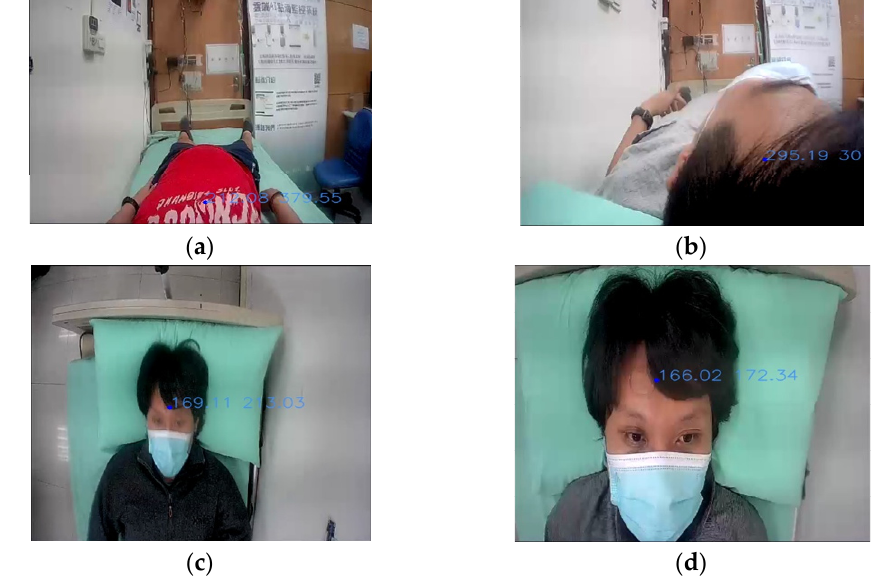
Figure 3. Images with four angles: ( a ) horizontal high; ( b ) horizontal low; ( c ) vertical high; ( d ) vertical low.